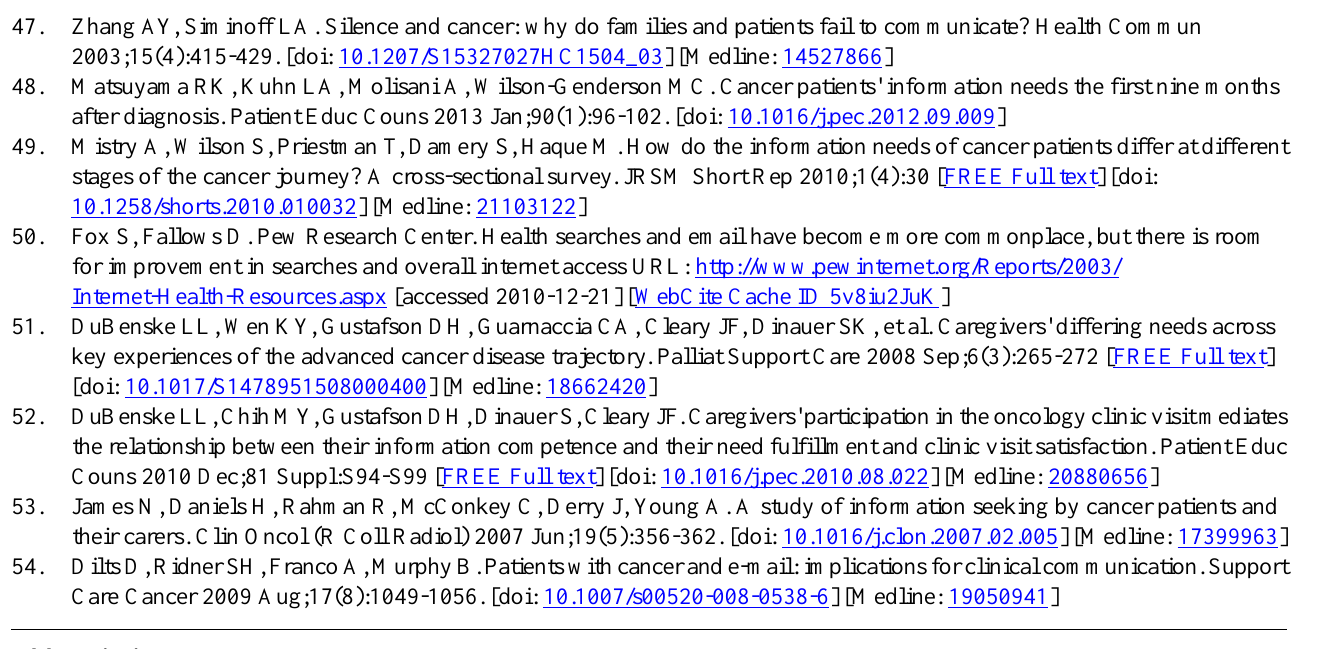
DLIC: Dutch Lung Cancer Information Center NSCLC: non–small cell lung cancer SCLC: small cell lung